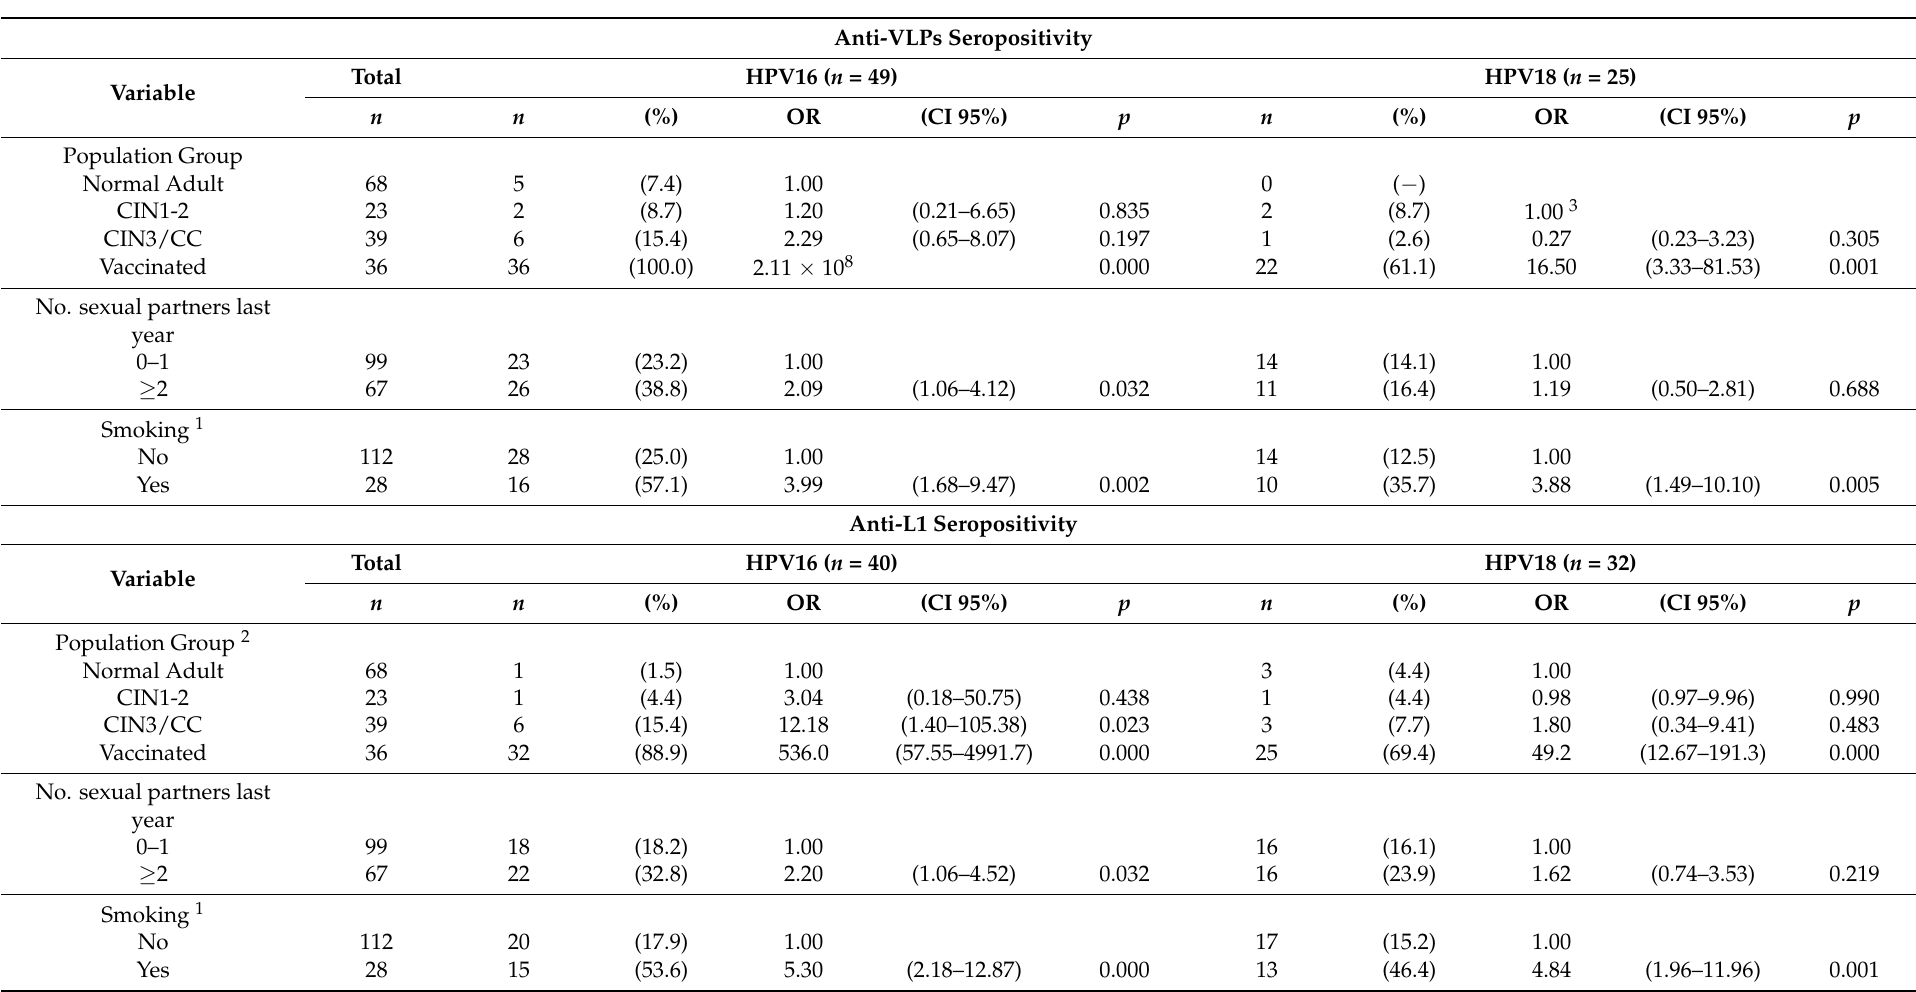
Table 2. Differential association of antibodies against VLPs and L1 from HPV16 and 18 in women with uterine cervical lesions and HPV-vaccinated. Anti-VLPs